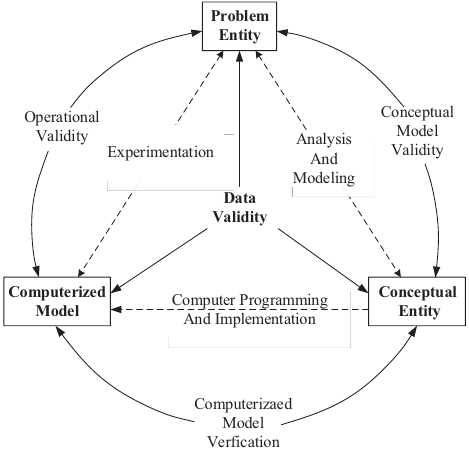
Figure 3. The model development